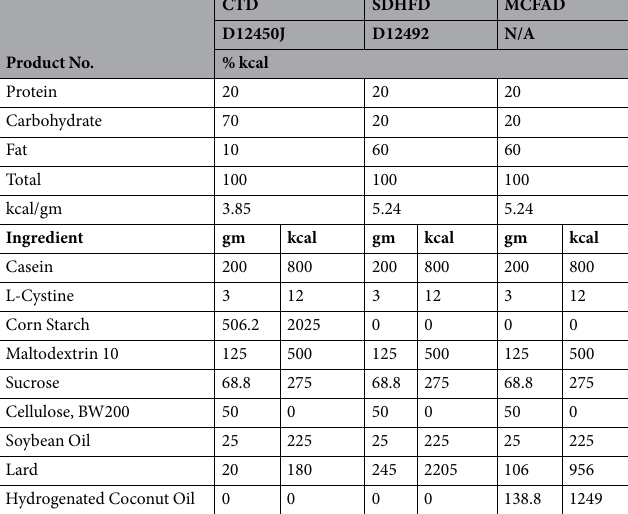
Table 1. Formulas of diets used in animal